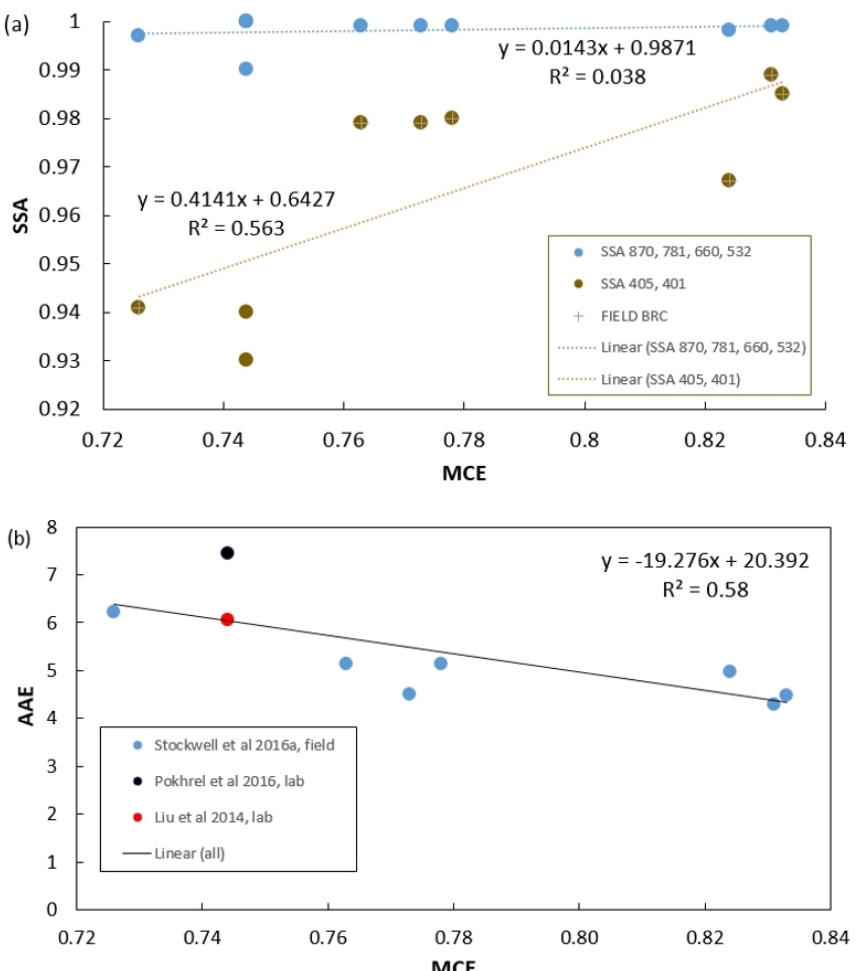
Figure 8. (a) SSA versus MCE measured in the range 870–532nm (blue). The lab data in this wavelength range (Liu et al., 2014; Pokhrel et al., 2016) are at MCE 0.744, and a value of one is reported in three cases. SSA versus MCE measured at 405 or 401nm (brown). + indicates field data from Stockwell et al. (2016a). The visible through near-IR SSA near one is consistent with extremely small BC content. More UV absorption by BrC is seen at lower MCE. (b) The AAE versus MCE with the equation used to calculate an average peat fire AAE at the field-average MCE of